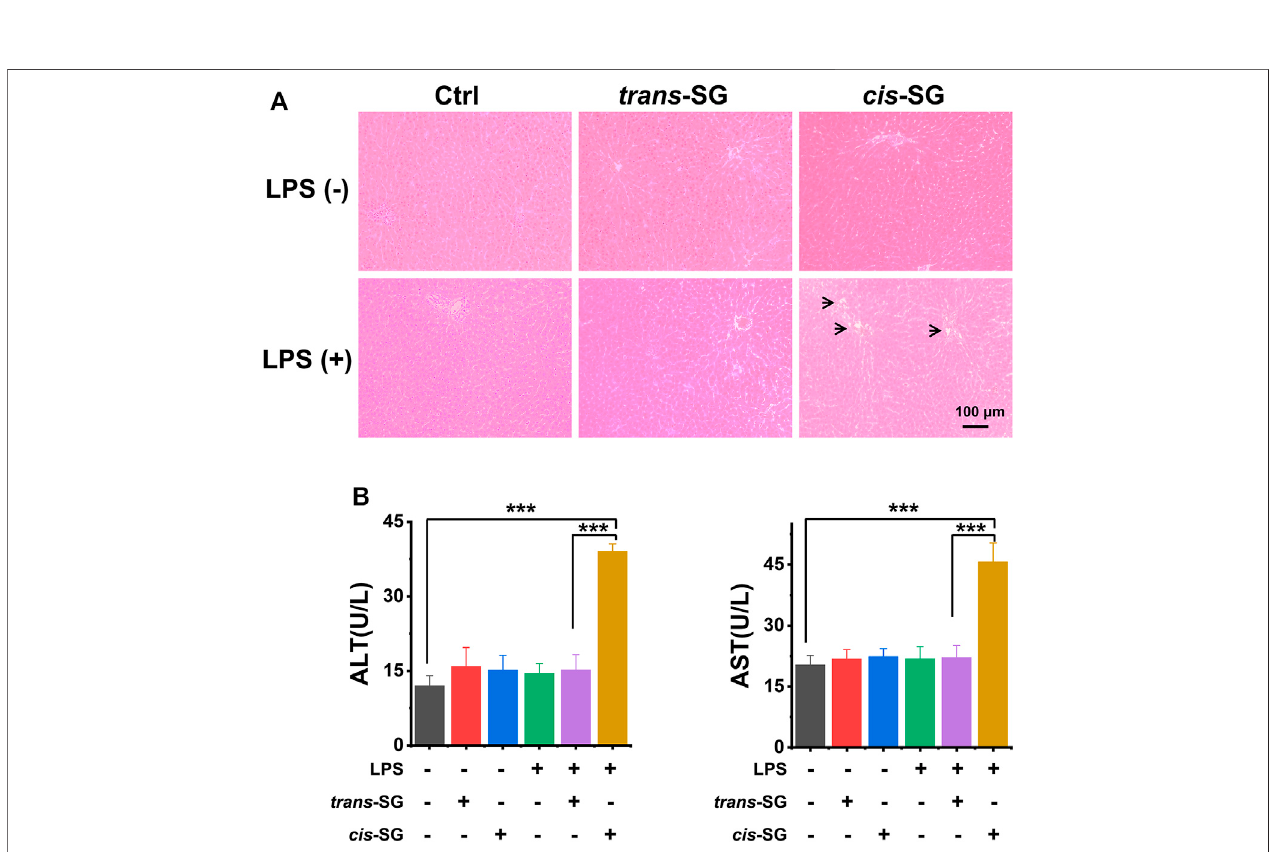
FIGURE2| Hepatotoxicityevaluationof trans-SG and cis-SG inLPS-treatedratmodel. (A) Thehistologicalanalysisoftheliversectionswiththetreatmentof trans- SG or cis-SG in the LPS-treated rat model ( n = 9). (B) The serum ALT and AST levels. Scale bar = 100 μ m. Values are expressed as mean ± SD. *** p < 0.001.